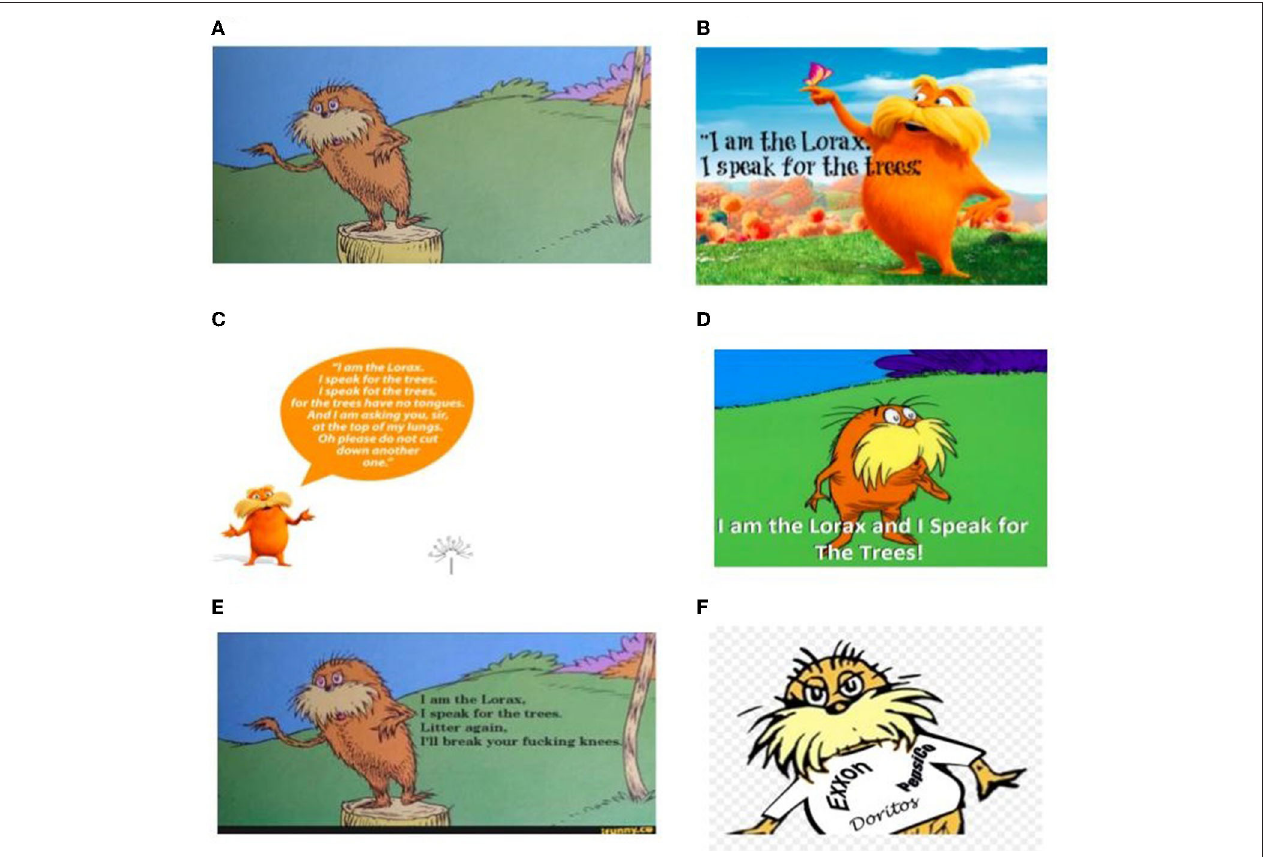
FIGURE 4 | Lorax characters. (A) Original illustration (Kimmel, 2019). (B) 2012 animation (Morye, 2020). (C) Animation with quote (https://www.pinterest.com/pin/ 428053139554374889/) 3 . (D) TV Cartoon Lorax (https://imgur.com/gallery/9pvVx1w) 4 . (E) Original illustration with text (https://www.pinterest.co.kr/pin/ 627055948099310315/?amp_client_id=CLIENT_ID(_)&mweb_unauth_id=&from_amp_pin_page=true) 5 . (F) Lorax wearing t-shirt (https://www.pinclipart.com/ pindetail/ibTTbih_the-lorax-youtube-clip-art-lorax-dr-seuss/) 6